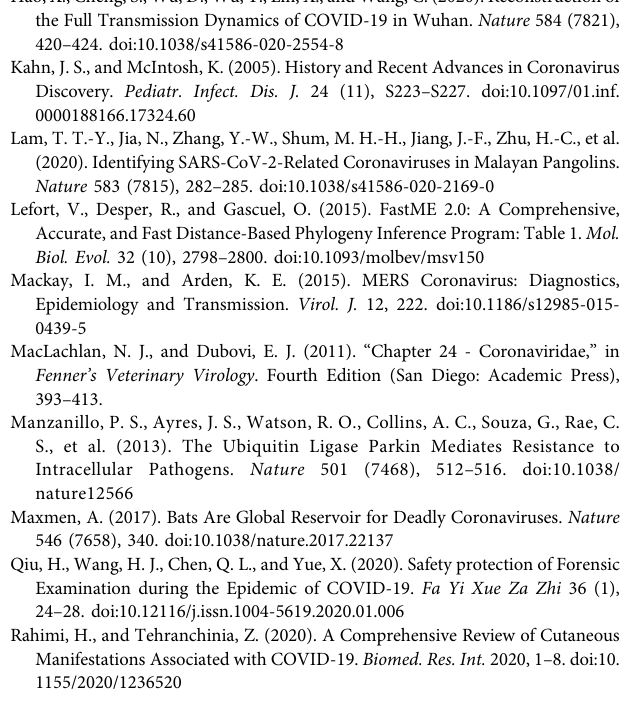
Supplementary Figure S1 | Details of different coronaviruses infected situation in Manis javanica . (A) . Heatmap of sequence coverage on the viral genome. (B) . Heatmap of total hits that aligned to the coronaviral genome. Supplementary Figure S2 | Assembled genome of two coronaviruses. (A) . Coverage of fragments isolated from virus infected Callithrix jacchus where the blue blocks mean consistent with MERS-CoV genome. (B) . Coverage of fragments isolated from virus infected Sus scrofa where the blue blocks mean consistent with PEDV genome. Supplementary Figure S3 | Receptor gene expression analysis. (A, B) . Heatmap of natural logarithm of mean expression of 24 respiratory receptor genes in tissue intestineand lungofdifferentspecies. (C) .Boxplotofnaturallogarithmof5receptor genes expression level between PRRSV infected and non-infected group in lung of sus scrofa . Supplementary Figure S4 | Binding af fi nity analysis of SARS S1 proteins with ACE2s among species. (A) . Schema of protein structure simulation and in-silico docking. (B) .Polarizedheatmapshowingthez-dockscoreofSARS-CoVS1protein and host ACE2 among species. (C) . Sequence logo of ACE2 binding interface to SARS-CoV S1ofallspecies andsequence logoofACE2 binding interface toSARS- CoV S1 of species with top 10 Z-dock score. (D) . The overlay of simulated and docked human ACE2 + SARS-CoV-2 S1 structure on